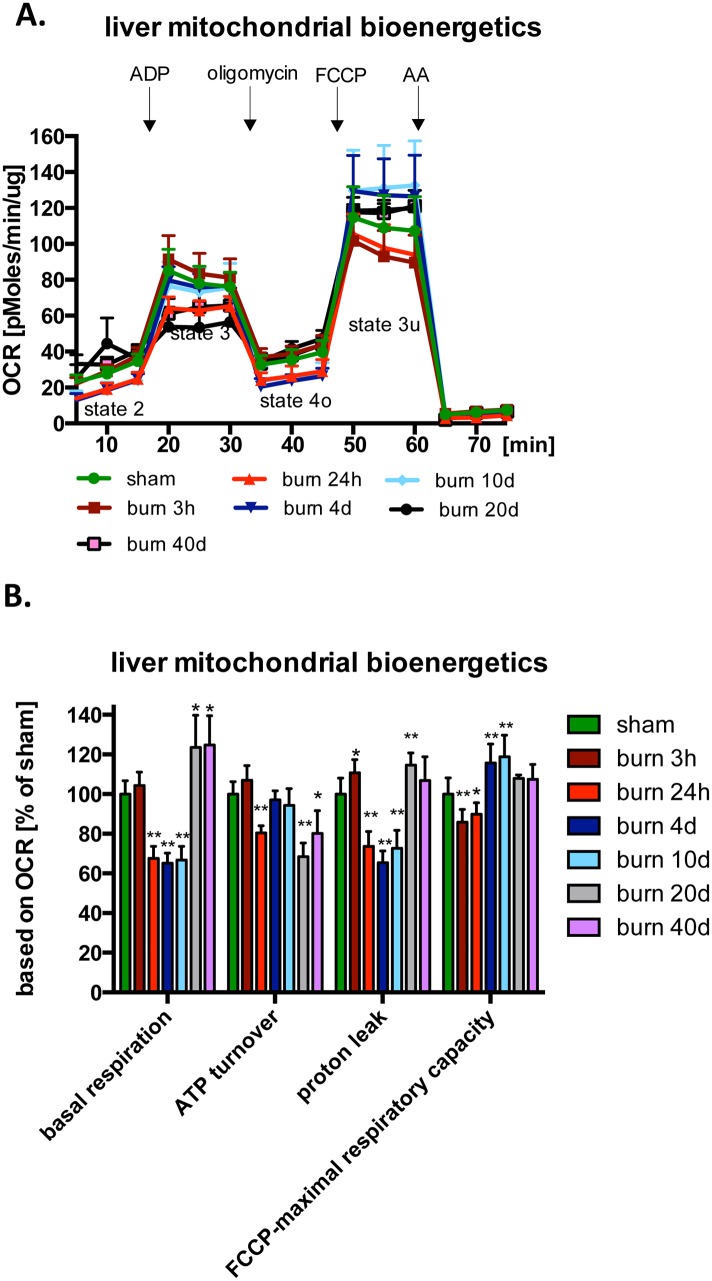
Burn injury induces time-dependent changes in the mitochondrial bioenergetics in the liver.Bioenergetic parameters of the isolated mitochondria from liver of mice subjected to burn injury were analyzed by Extracellular Flux Analysis. (A) Traces of oxygen consumption of mitochondria isolated from sham or burn injured animals at various time points post burn injury are shown. (B) Calculated bioenergetics parameters are shown. The results are based on n = 6 per group and represent mean±SD. *, ** p<0.05 and p<0.01 respectively, relative to sham animals.